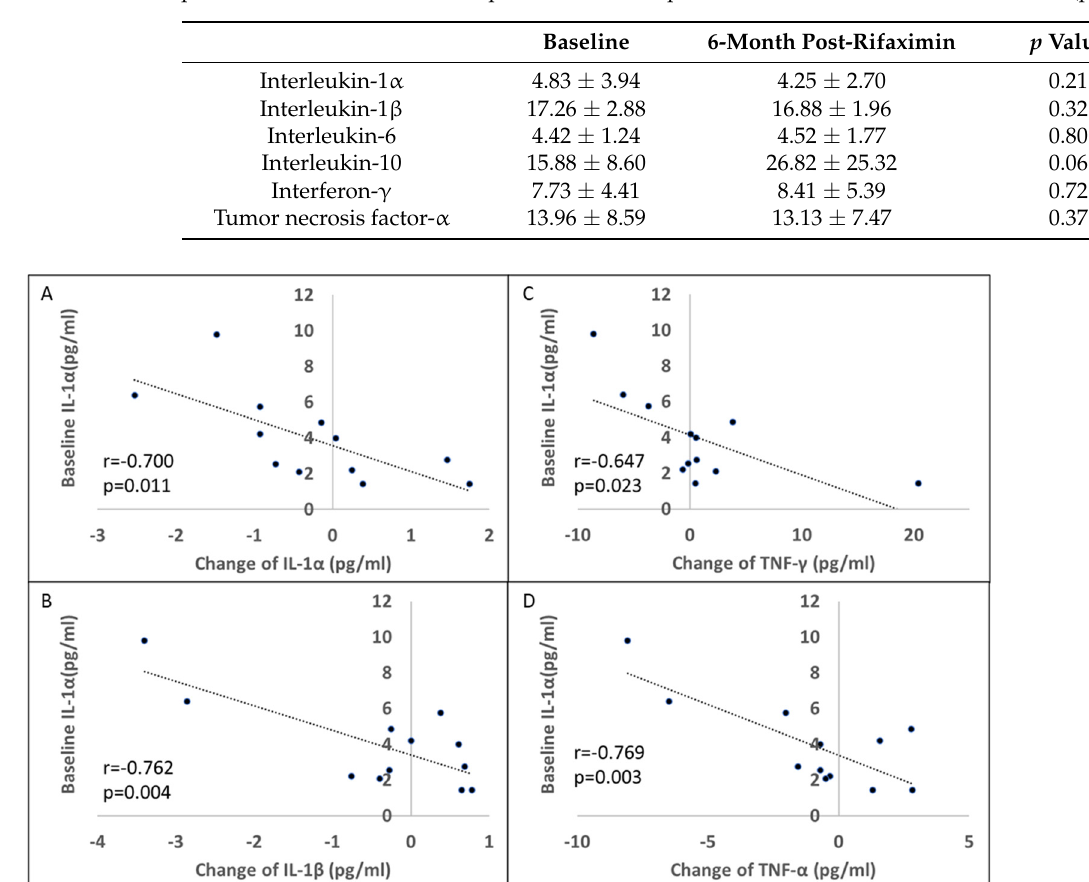
Figure 6. Effect of 7-day rifaximin on patients with PD: Association with baseline interleukin (IL)-1 α . The association between the baseline plasma IL-1 α level and changes in plasma IL-1 α (A), IL-1 β (B), IFN- γ (C), and TNF- α (D) levels before and 6 months after 7-day rifaximin treatment. Table 2. Serum Cytokine profile. The change in serum cytokine level between baseline and 6-month post-rifaximin treatment in PD patients. Data are presented as mean ± standard deviation (pg/mL).